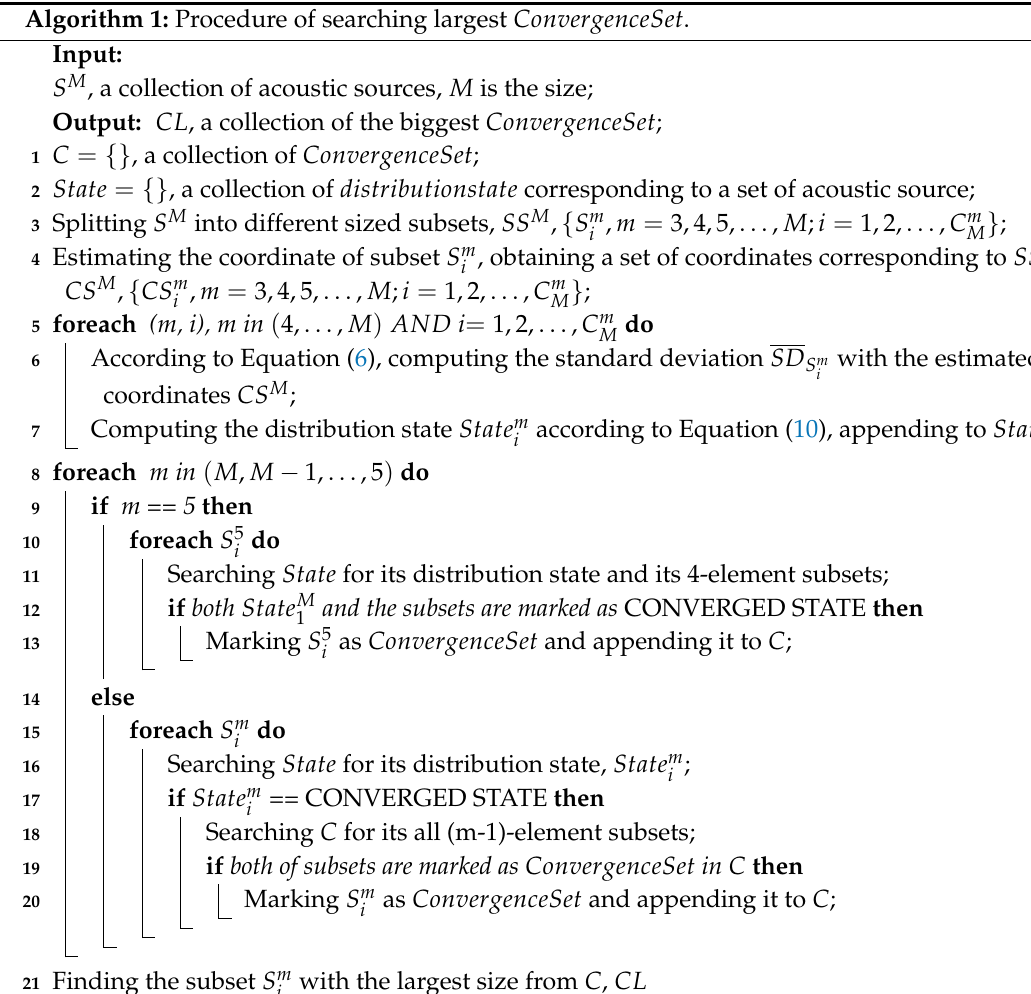
Algorithm 1: Procedure of searching largest ConvergenceSet